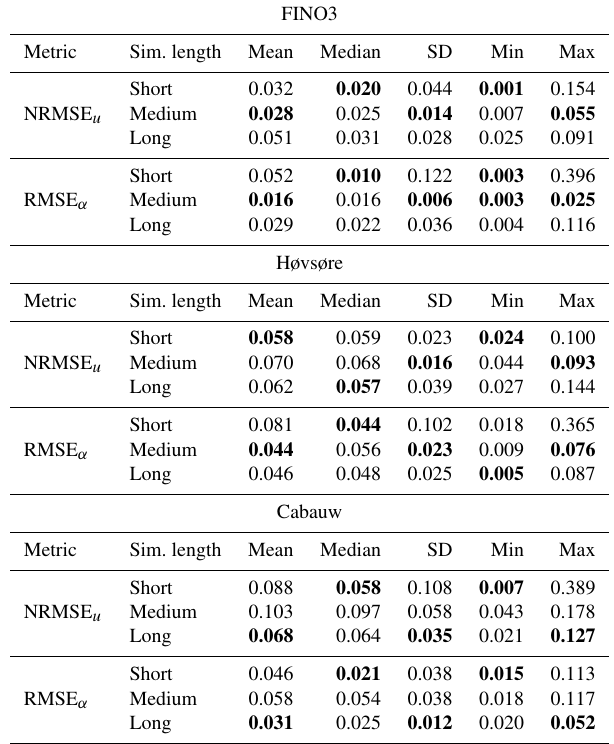
Table 7. Statistics of NRMSE for wind speed (NRMSE u ) and RMSE for wind speed shear exponent (RMSE α ) associated with each group of simulation lead time across all heights at each site. There are nine models in the short group, eight in the medium group, and seven in the long group. The smallest value for each metric is in bold. FINO3